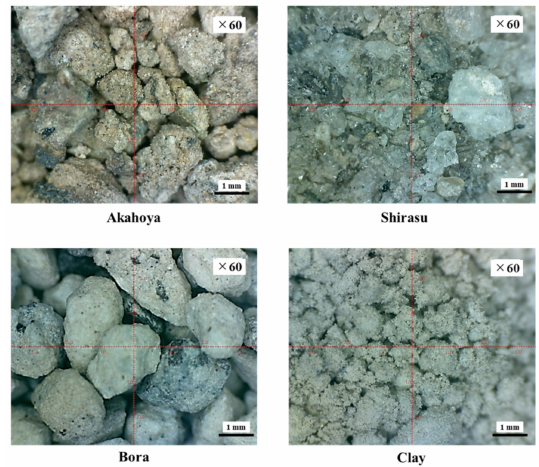
Figure 2. Microscopy images of